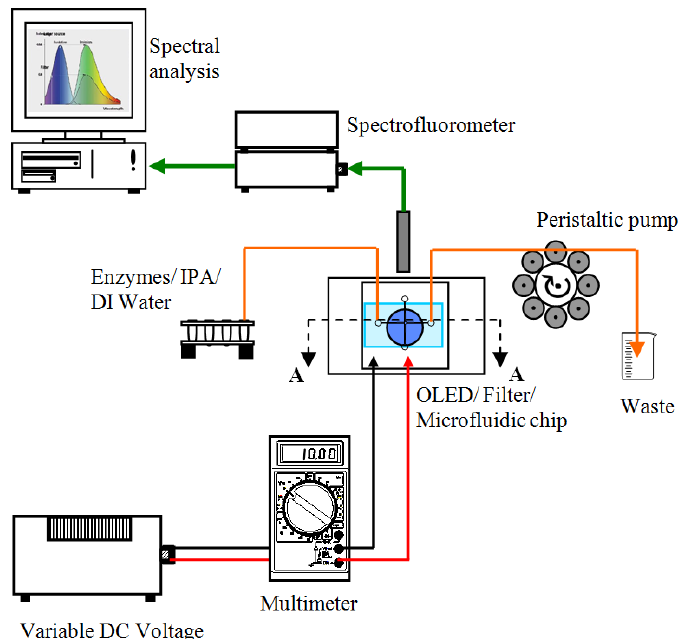
Figure 8. Schematic representation of the bio-optical fluorescence detection setup using OLED source.